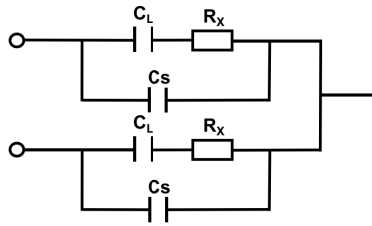
Figure 2. The equivalent circuit model of DIC 4 D.